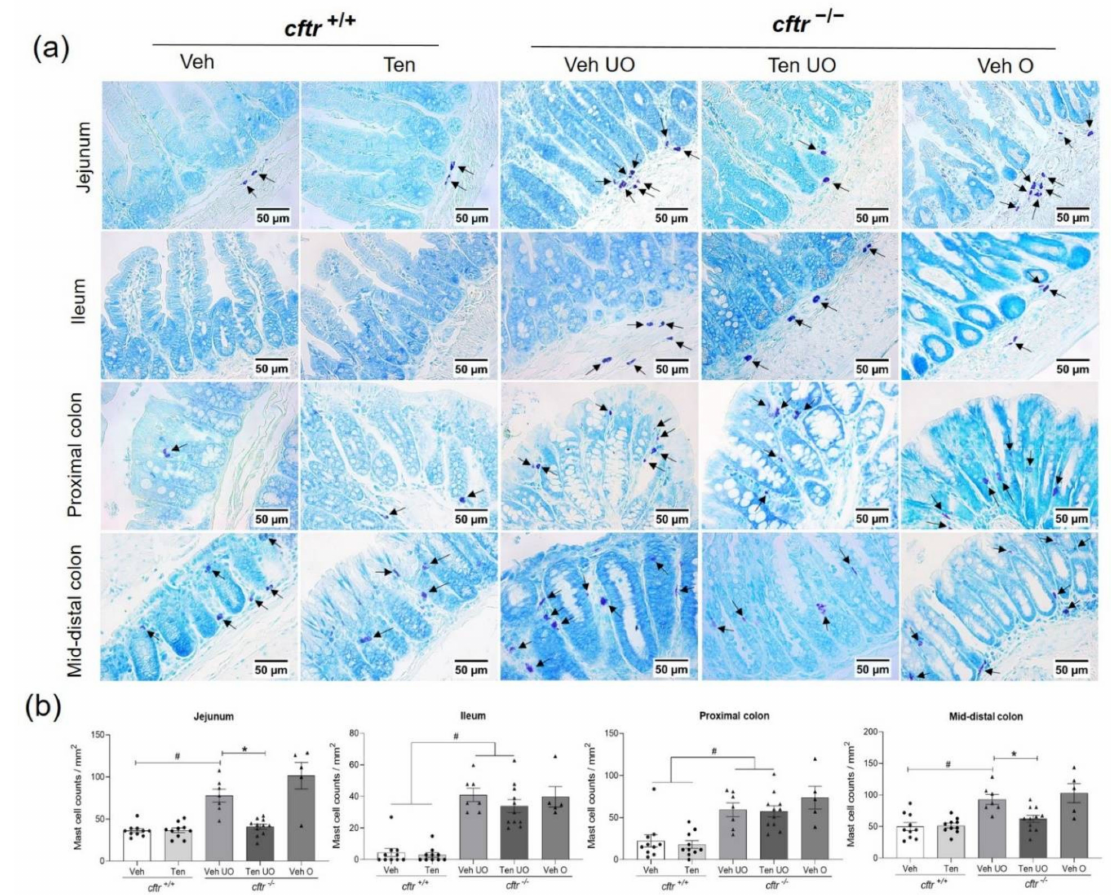
Figure 6. Reduced numbers of mast cells in tenapanor-treated cftr − / − mice. ( a ) Representative images of Toluidine Blue-stained mast cells (indicated by black arrows) in the jejunum, ileum, proximal colon, and mid-distal colon in cftr +/+ and cftr − / − mice treated with either the vehicle or tenapanor. ( b ) Quantified mast cell counts within the selected intestinal segments. Each dot/triangle represents one mouse. Veh—vehicle, Ten—tenapanor, UO—unobstructed, O—obstructed. Data are represented as means ± SEM. # is used to represent the statistical analysis performed between the two different genotypes and * is used to represent the statistical analysis performed between the vehicle and tenapanor groups. # and *, p <